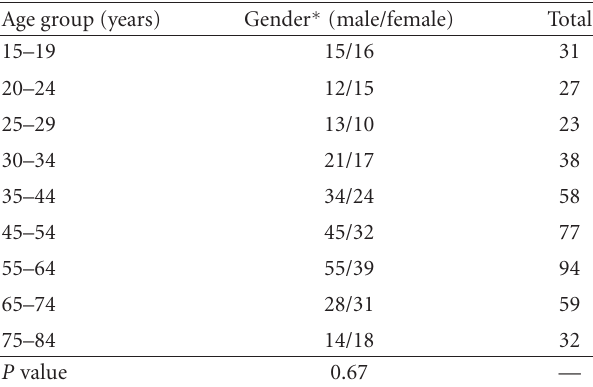
∗ Chi-square test for categorical data in di ff erent age groups ( P value > 0.0.5 does not indicate statistically significant di ff